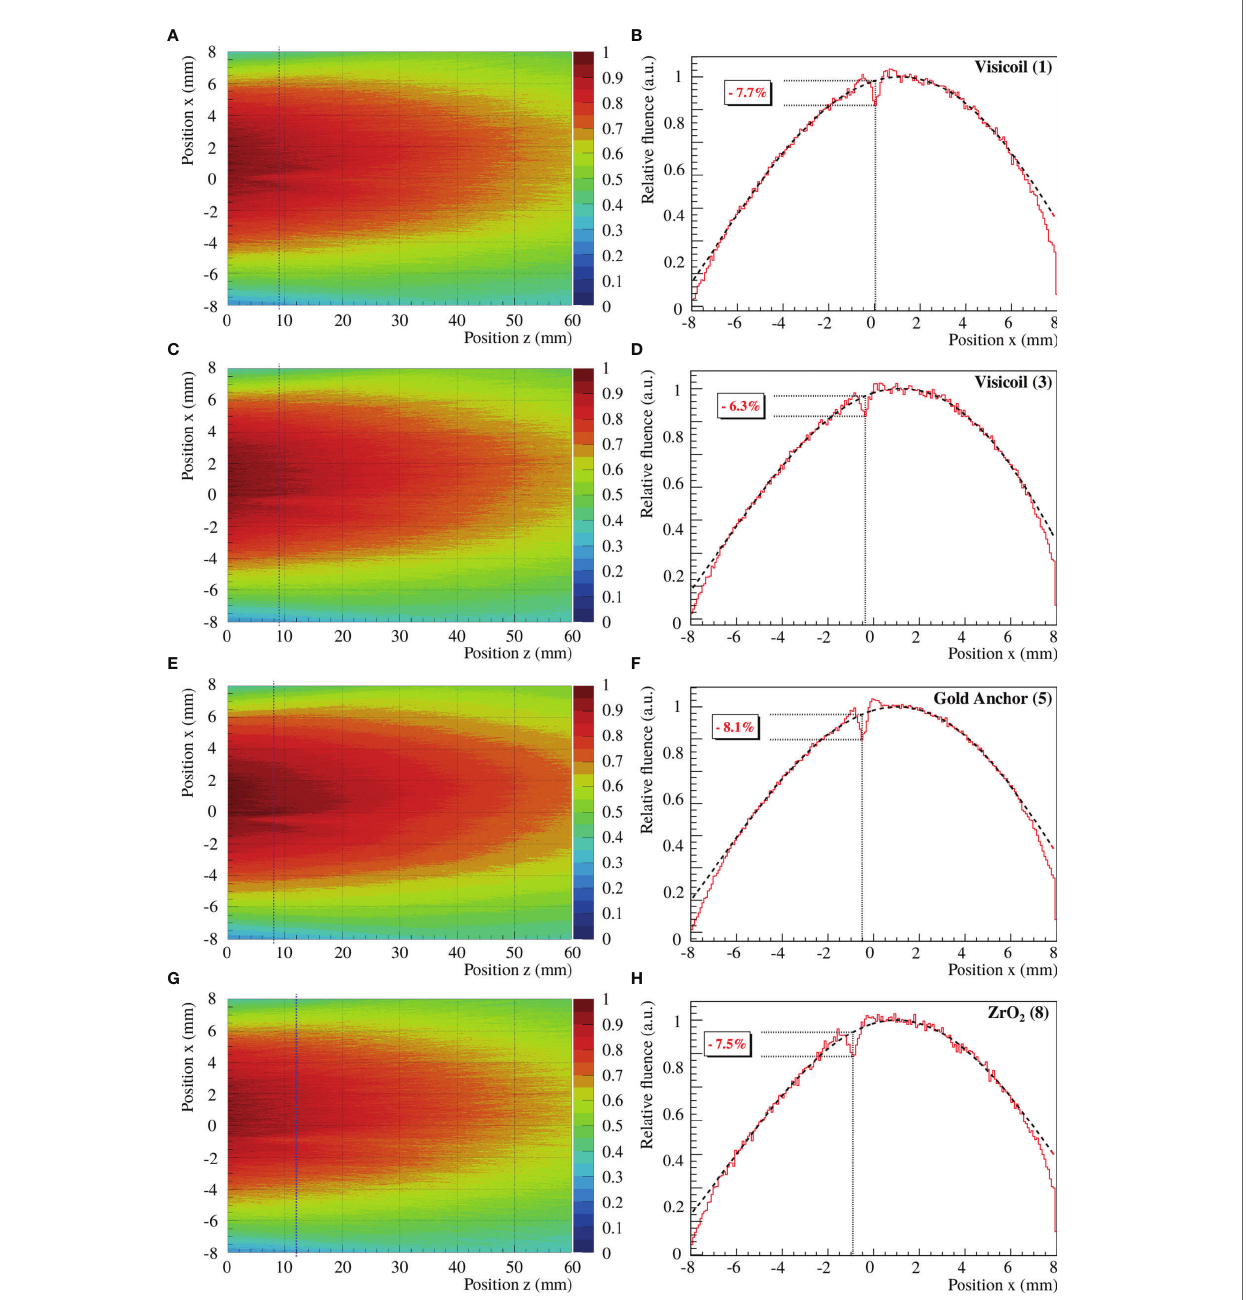
FIGURE 9 | (A, C, E, G) show the fl uence maps reconstructed from all tracks. (B, D, F, H) show their corresponding pro fi le at the z position where the perturbation is the strongest. The black vertical dash-dotted line on the fl uence map represents the corresponding position along the beam axis where the fl uence perturbation is maximum. In (B, D, F, H) , the red line shows the pro fi le at this position with the marker, while the black line shows the pro fi le without marker for the same z position. In the same panels, the vertical dotted line indicates the position in x of the maximum perturbation while the dotted horizontal lines quantify the strength of the